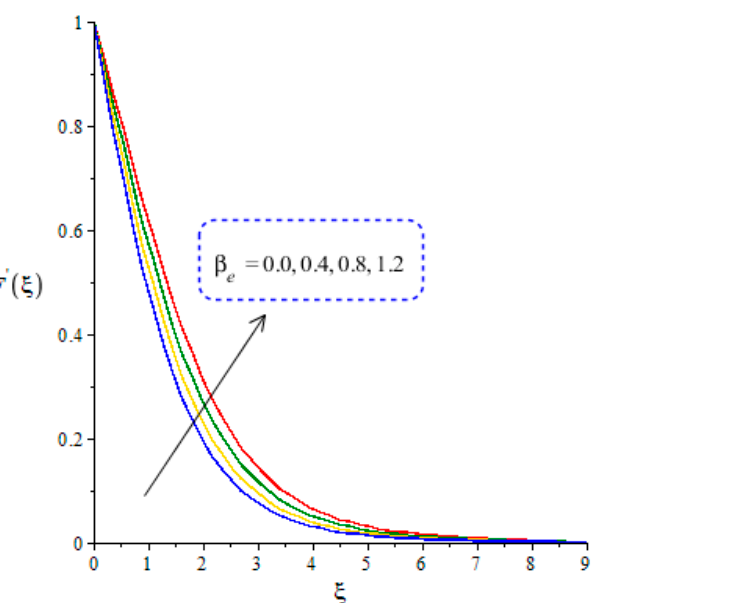
(cid:48) ( ξ ) versus F r when m = 0.01, We = 5,